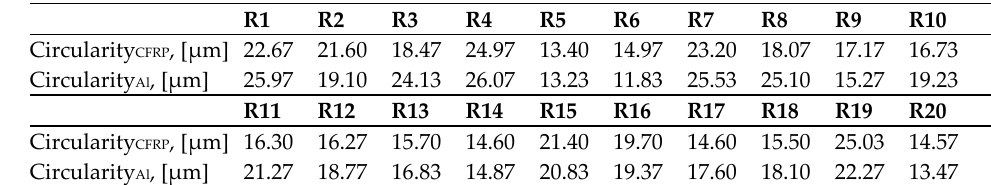
Figure 19. Hole circularity between stack-up materials for all runs in the extended study.